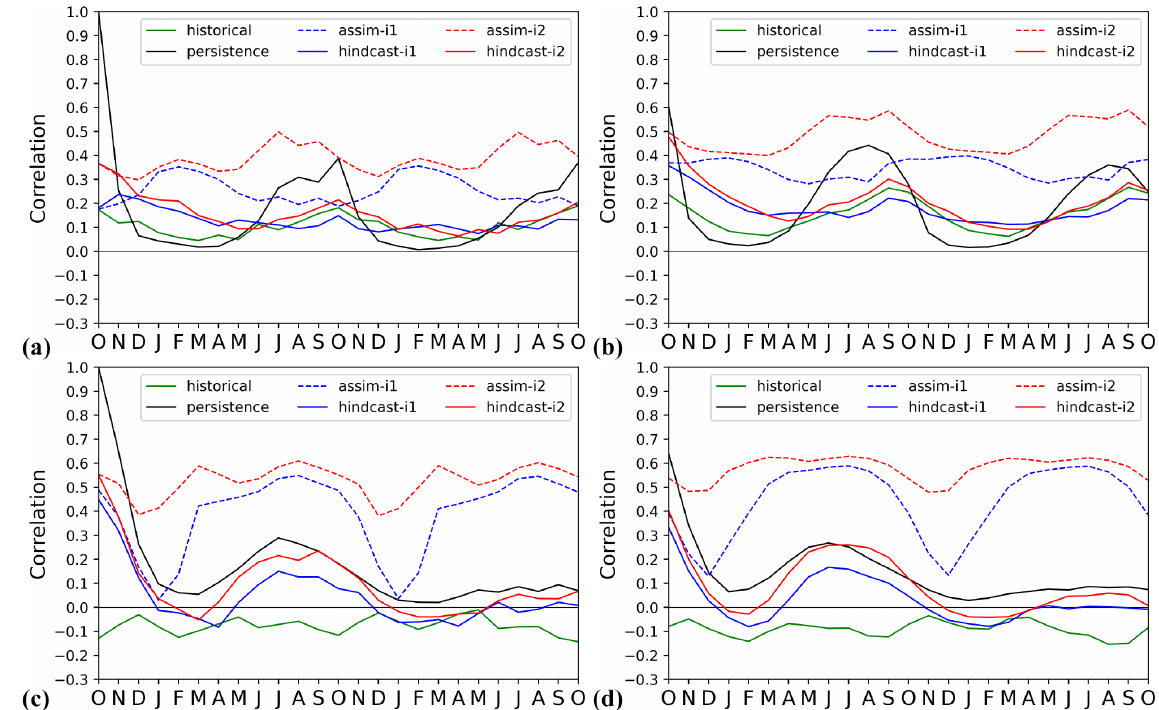
Figure 18. Hemispheric correlation skill for Arctic (a, b) and Antarctic (c, d) ice area as a function of lead month for monthly averages (a, c) and 3-month averages (b, d) . The data are first interpolated to a 5 ◦ × 5 ◦ grid and correlations are then computed jointly over space and time, applying area weighting and only considering grid cells with non-zero temporal standard deviations. The persistence forecast uses the observed October mean, while the hindcasts were initialized 1 November. Observations are from HadISST1 (Rayner et al., 2003) and limited to the satellite era